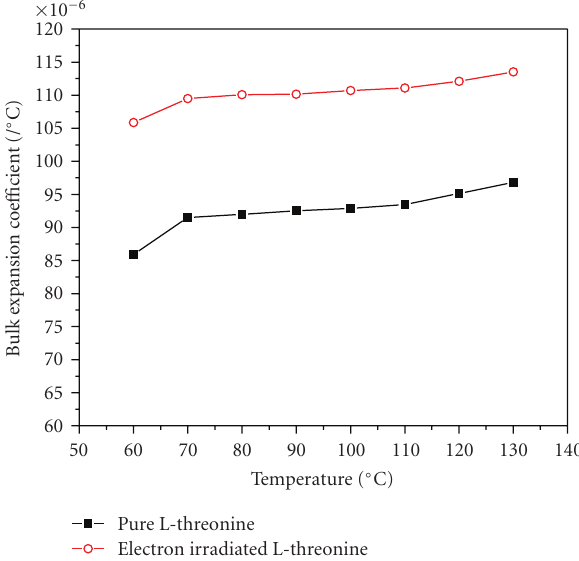
Figure 48: Bulk expansion coe ffi cient versus temperature of pure and electron-irradiated L-threonine crystal at 12 × 10 14 e/cm 2